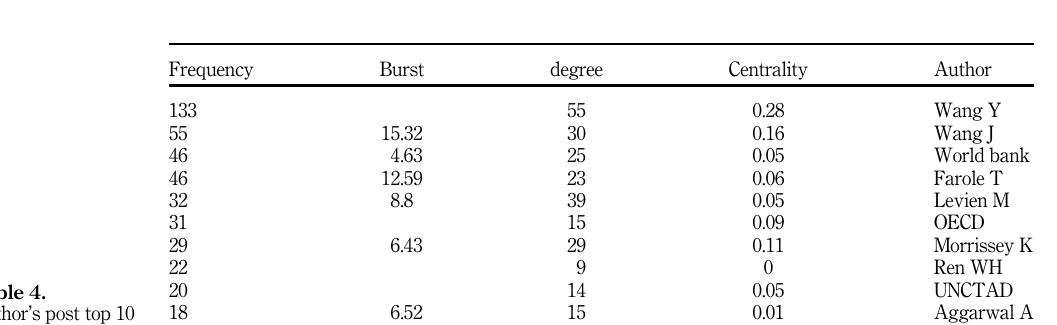
Figure 5. Author cooperation